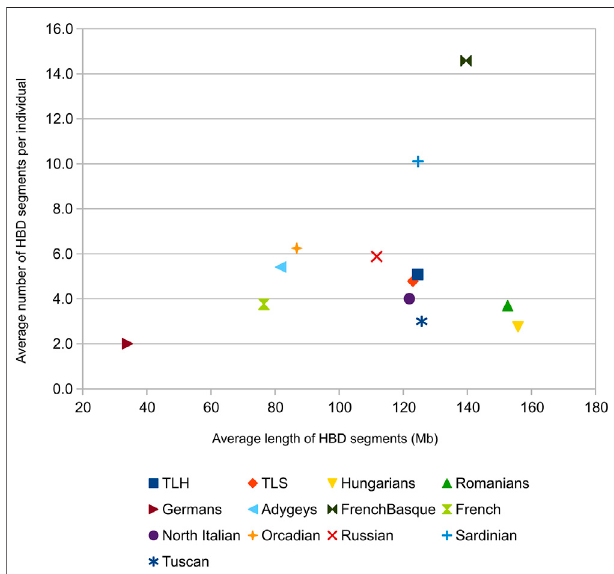
FIGURE 5 | Homozygous-by-descent segment analysis results.